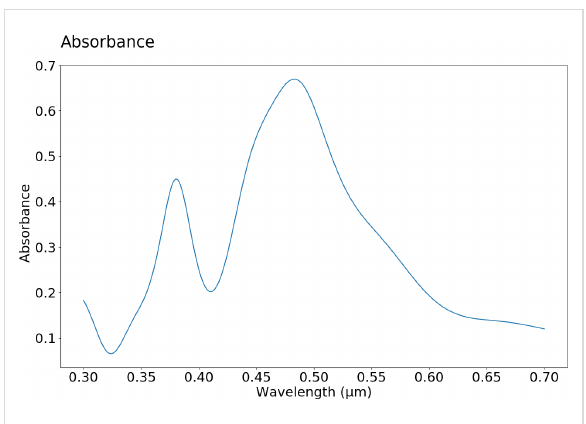
Figure 16: Calculated absorbance log( Φ i / Φ t ), where Φ i and Φ t are inci- dent and transmitted flux, respectively, as the function of the incident light